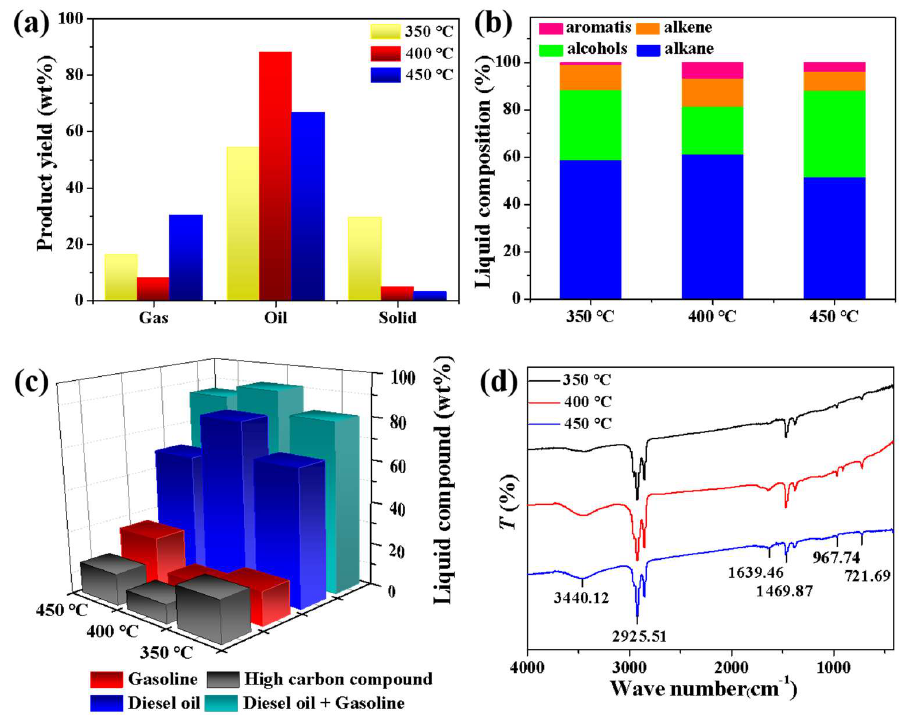
Figure 5. Product tests after thermal catalytic cracking of waste LDPE with NMGM at different reaction temperatures for 1 h ( a ) yield, ( b ) hydrocarbon composition distribution of liquid products, ( c ) liquid product‒composition distribution, ( d ) FTIR test.